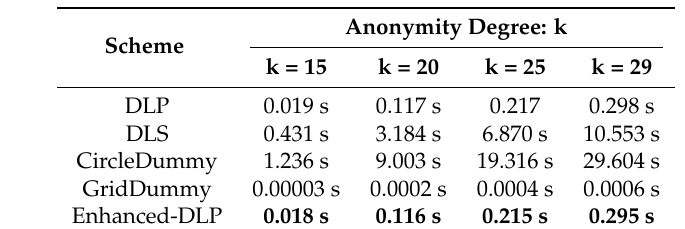
Figure 3. Scenario 1: Entropy and run time. Table 1. Run times for Scenario